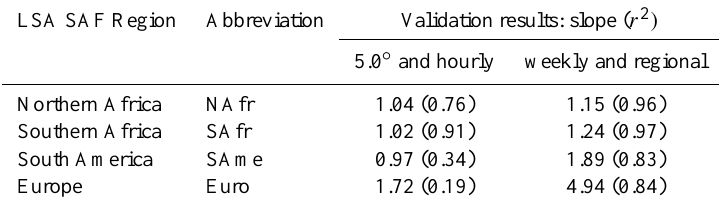
Table 3. Summary of the results related to evaluation of the regional bias adjustment factors implemented during the processing of the LSA SAF FRP-GRID product. Slope of the linear best fit between the SEVIRI-predicted regional FRP using the FRP-GRID bias adjustment factors and the FRP measured by MODIS over the same areas are shown, as are the coefficients of determination ( r 2 ), at both 5 ◦ and hourly resolution (which is the native FRP-GRID product resolution) and also at a weekly resolution accumulated over the entire LSA SAF geographic